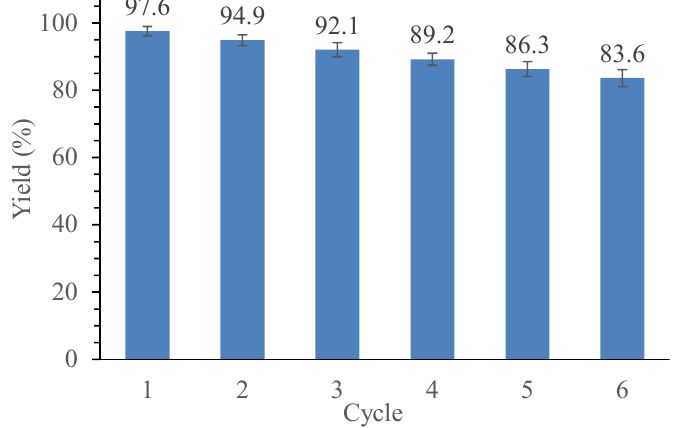
Figure 9. Reusability of calcium/titania-zirconia catalyst in the esterification reaction.